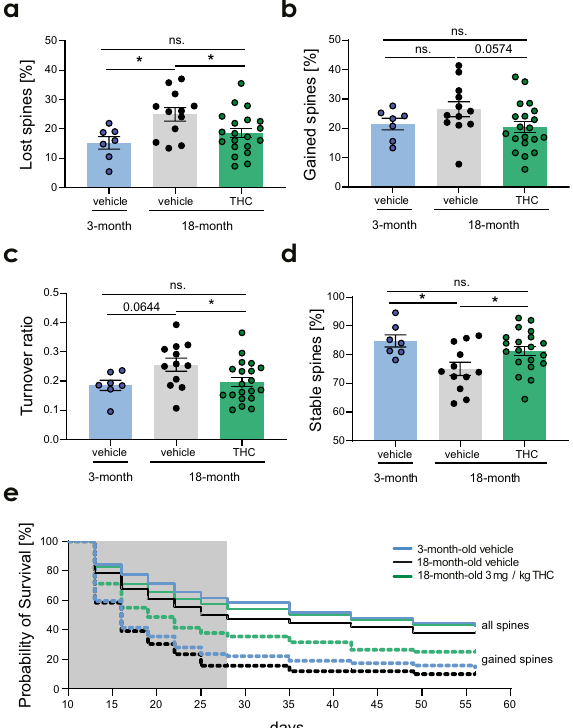
Figure 3. THC counteracts the effects of aging on the level of spine dynamics. Percentage of spines that were lost ( a ) or gained ( b ). ( c ) Turnover ratio—number of lost and gained spines between two consecutive time points divided by the total number of spines in both time points. ( d ) Percentage of spines that were stable between two consecutive time points. Spine dynamics from day 13 to day 16 of the treatment. For 3-month-old mice (n = 7 ROIs), for 18-month-old mice (n = 12–20 ROIs / treatment). Each data point represents one ROI. Data was analyzed using one-way ANOVA and Dunnett’s multiple comparison test for comparison of 3-months old vehicle group with the 18-month-old vehicle and THC-treated groups. Differences between the 18-month- old vehicle and THC groups were detected using unpaired t-test. ( a ) Group effect F 2,36 = 4.755, p = 0.0147 (3- vs. 18-month-old vehicle p = 0.0129); 18-month-old vehicle vs. THC t 30 = 2.321, p = 0.0273; ( b ) group effect F 2,36 = 2.244, p = 0.1207; ( c ) group effect F 2,36 = 3.462, p = 0.0422 (3- vs. 18-month-old vehicle p = 0.0644); 18-month-old vehicle vs. THC t 30 = 2.241, p = 0.0326 ( d ) group effect F 2,36 = 4.755, p = 0.0147 (3- vs. 18-month- old vehicle p = 0.0129); 18-month-old vehicle versus THC t 30 = 2.321, p = 0.0273. ( e ) Survival probability of spines that were gained between day 7 and day 10 (dashed line) of the treatment and all spines that were present at day 10 (full line). THC treatment elevated spine survival of all spines in old mice to the level of young vehicle-treated mice; while spine survival in vehicle treated old mice was significantly reduced (all spines 3- vs. 18-months-old vehicle groups: p = 0.0023). THC-treatment also increased the survival of gained spines notably in comparison to the 3-months-old vehicle group (3-month-old vehicle group vs. 18-month old THC group: p = 0.0076). For survival probability analysis Kaplan–Meier plot and log rank test (Mantel-Cox test) were used. Grey box indicates the treatment duration. Error bars indicate mean ± SEM; * P < 0.05, ** P < 0.01, *** P < 0.001. ns. - not